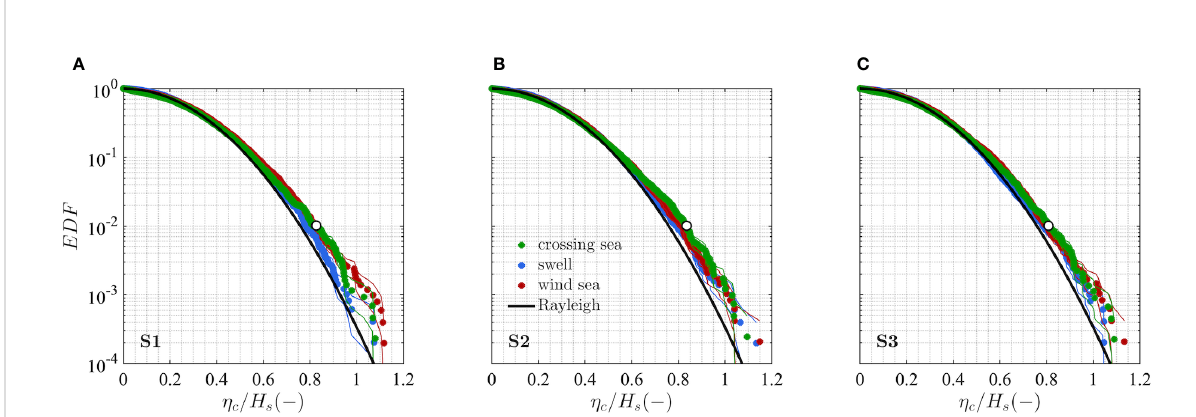
FIGURE 7 Ensemble exceedance distribution functions of dimensionless crest heights ( h c /H s ) at a fi xed point of the numerical domain for sea conditions S1 (A) , S2 (B) and S3 (C) . Wind sea (solid red line), swell (solid blue line) and total (solid green line) are compared. The 99 th percentile value for